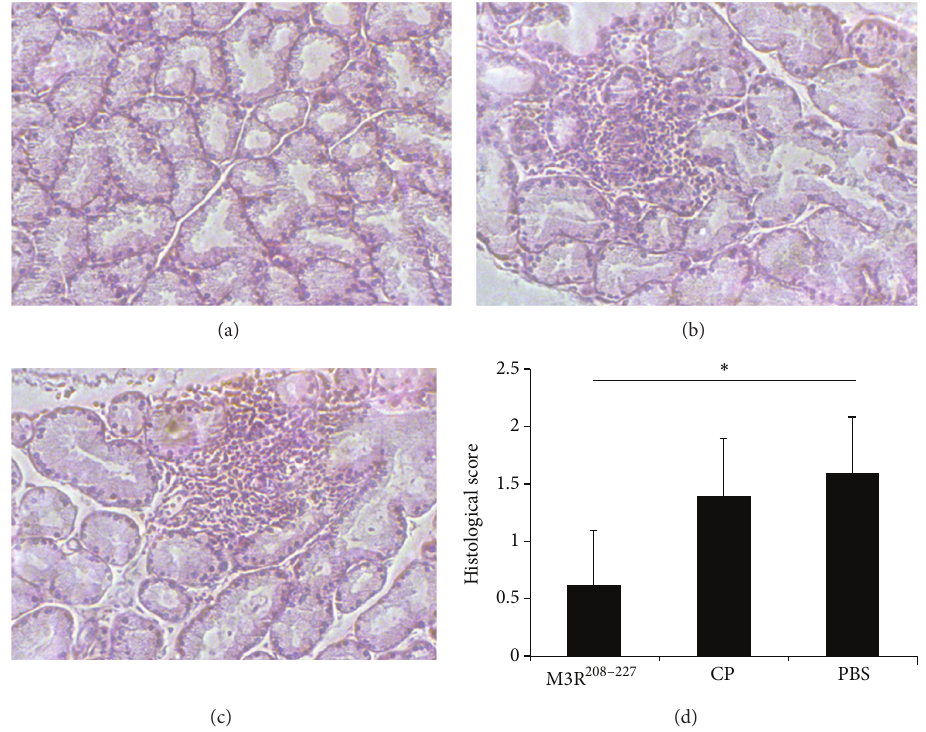
Figure 6: Lymphocytic infiltration was improved in the lacrimal glands following immunization with the M3R 208−227 peptide. Whole lacrimal glands of NOD/LtJ mice were surgically removed from each mouse and placed in 10% phosphate-buffered formalin for 20min. After the samples were fixed, embedded, and stained with hematoxylin and eosin (H&E), sections were observed under a microscope. The histological analysis suggested that immunization with M3R 208−227 could reduce the lymphocytic infiltration in the lacrimal glands of NOD/LtJ mice. (a) Tissue from a NOD/LtJ mouse immunized with the M3R 208−227 peptide. (b) Tissue from a NOD/LtJ mouse immunized with CP. (c) Tissue from a NOD/LtJ mouse immunized with PBS. (d) Mean grade (histological score) of inflammatory lesions in lacrimal glands of NOD/LtJ mouse immunized with the M3R 208−227 peptide as compared to the controls ( ∗ 𝑃 < 0.05 ). tends to be pathogenic and, in addition, Naito et al.